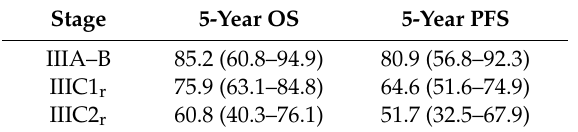
FIGO, International Federation of Gynecology and Obstetrics. OS, overall survival; PFS, progression- free survival. Data are % (95% confidence intervals).